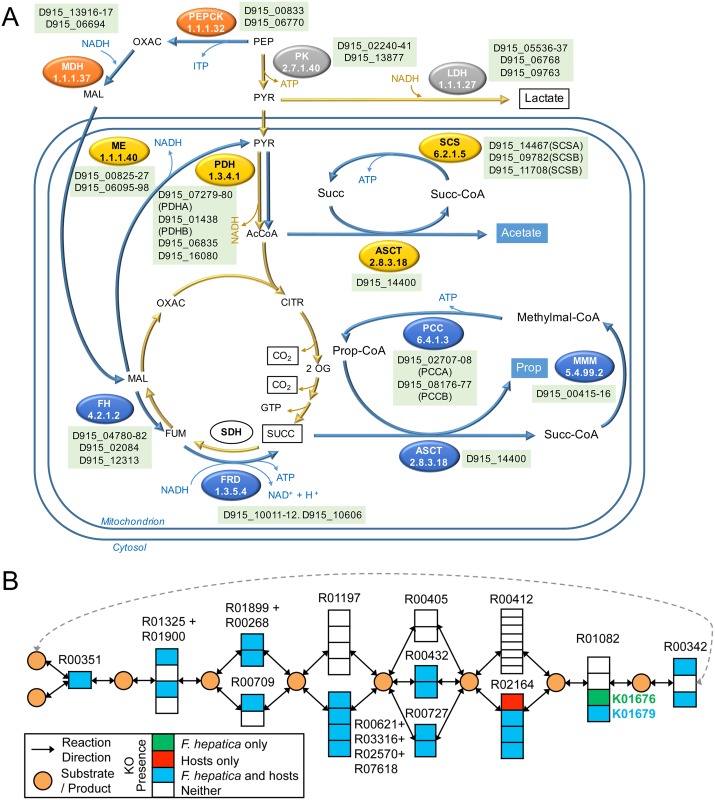
Metabolic pathways in F. hepatica.(A) Energy metabolism in anaerobic mitochondria of F. hepatica by malate dismutase. While the classical anaerobic fermentation to lactate is present (enzymes indicated in gray) when oxygen tension is low, the malate dismutation pathway is preferred (blue arrows). Phosphenol pyruvate reduction to malate occurs in the cytoplasm (orange). Within the mitochondria, part of the malate is oxidized to acetate (yellow) while other fraction reduced to succinate and further transformed to propionate (blue). Genes predicted for key enzymes involved in anaerobic respiration are indicated. Abbreviations: PEP, phosphenolpyruvate; OXAC, oxaloacetate; MAL, malate; FUM, fumarate; SUCC, succinate; PYR, pyruvate; AcCoA, acetyl-CoA; CITR, citrate. Enzymes indicated are: PK, pyruvate kinase; LDH, lactate dehydrogenase, PEPCK, phosphenolpyruvate carboxykinase (ATP dependent); MDH, malate dehydrogenase; ME, malic enzyme; PDH, pyruvate dehydrogenase; ASCT, acetate:succinate CoA-transferase; SCS, succinyl-CoA synthetase; FH, fumarate hydratase; FRD, fumarate reductase; SDH, succinate dehydrogenase, MMM methylmalonyl-CoA mutase; PCC, propionyl-CoA carboxylase. (B) Parasite specific enzyme usage in TCA cycle. The KEGG module for TCA cycle (M00009) is shown with groups of orthologous enzymes indicated using KEGG orthology (KO) IDs. An interesting example of alternate enzyme usage is shown for fumarate hydratase (reaction R01082), catalyzed by a class II enzyme (EC 4.2.1.2B; K01679) in both the host and parasite. However, F. hepatica also has a Platyhelminthes-specific class I fumarate hydratase (EC 4.2.1.2A; K01676), not annotated in any of the host proteomes. Such knowledge can be leveraged to design worm specific therapies with potentially low (or no) impact on the host health.